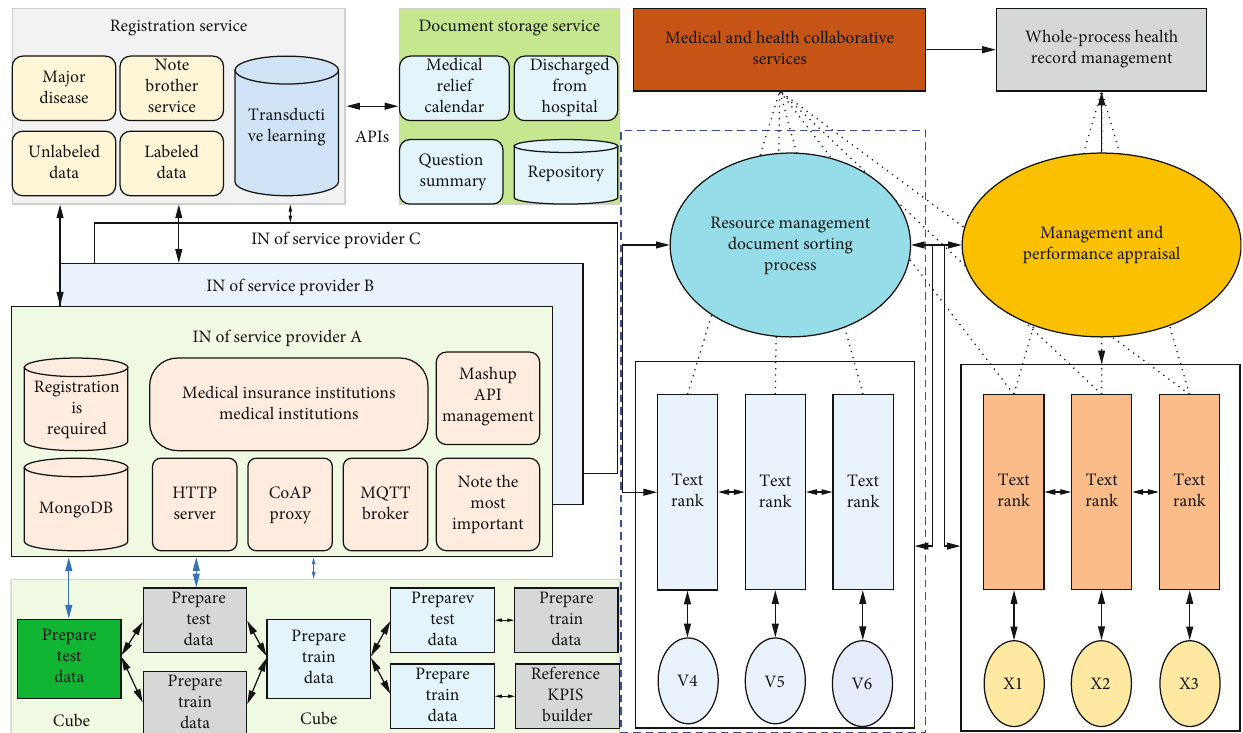
Figure 1: Architecture of medical sharing and collaboration